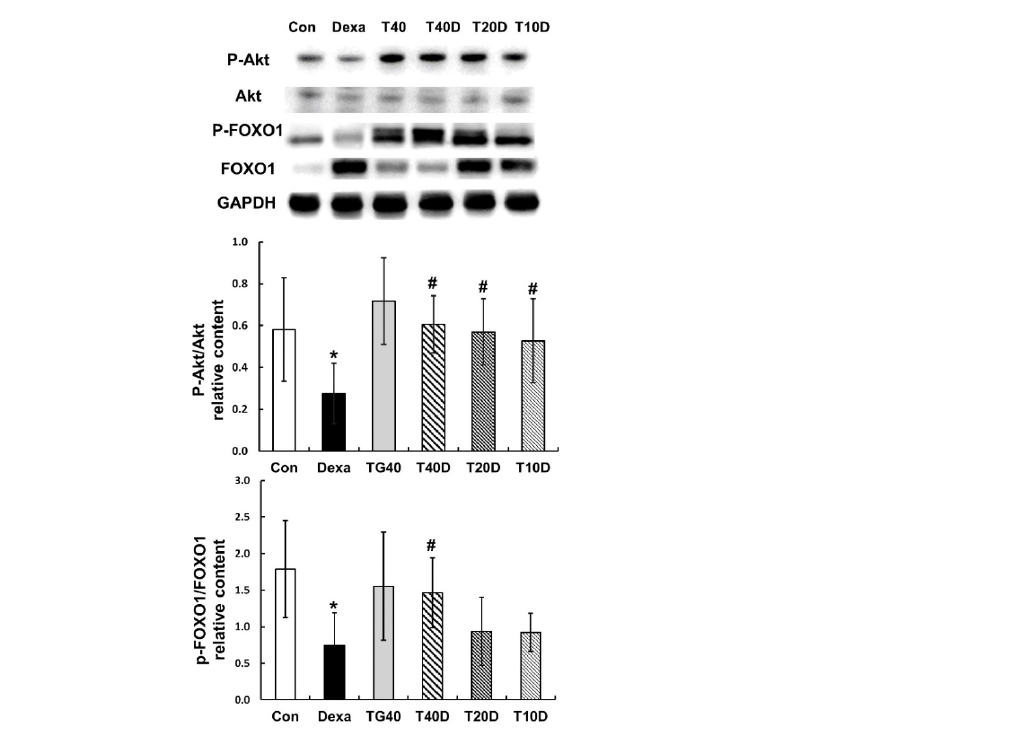
Figure 5. Effects of teaghrelin on Akt/FOXO1 phosphorylation in the gastrocnemius muscles of Dexa-treated rats. At the end of experiment, the phosphorylation levels of Akt and FOXO1 were measured in the gastrocnemius muscles of Dexa-treated rats by Western blotting with antibodies against Akt, P-Akt, FOXO1 and P-FOXO1. GAPDH was used as a loading control. The Con, Dexa, TG40, T10D, T20D and T40D groups are defined in Figure 1. The results were analyzed using one-way ANOVA. Values are presented as the mean ± SD (n = 5 or 6). * p < 0.05 versus Con; # p < 0.05 versus Dexa.